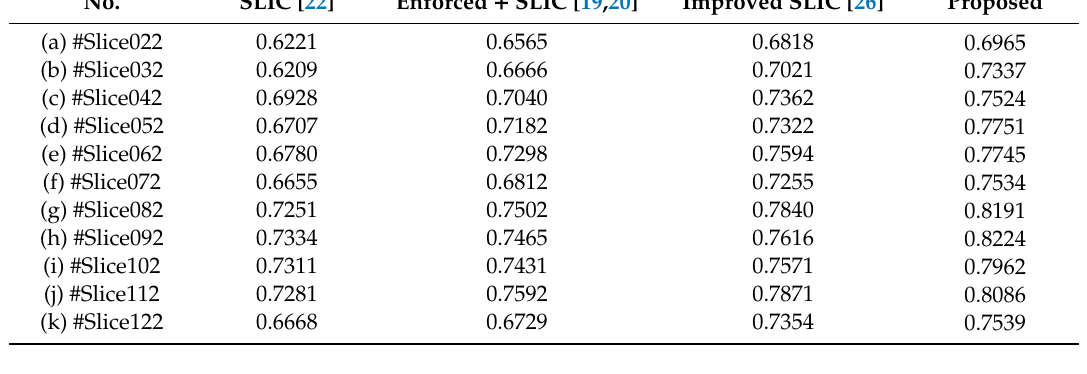
Table 2. The comparison of the boundary match of di ff erent algorithms.